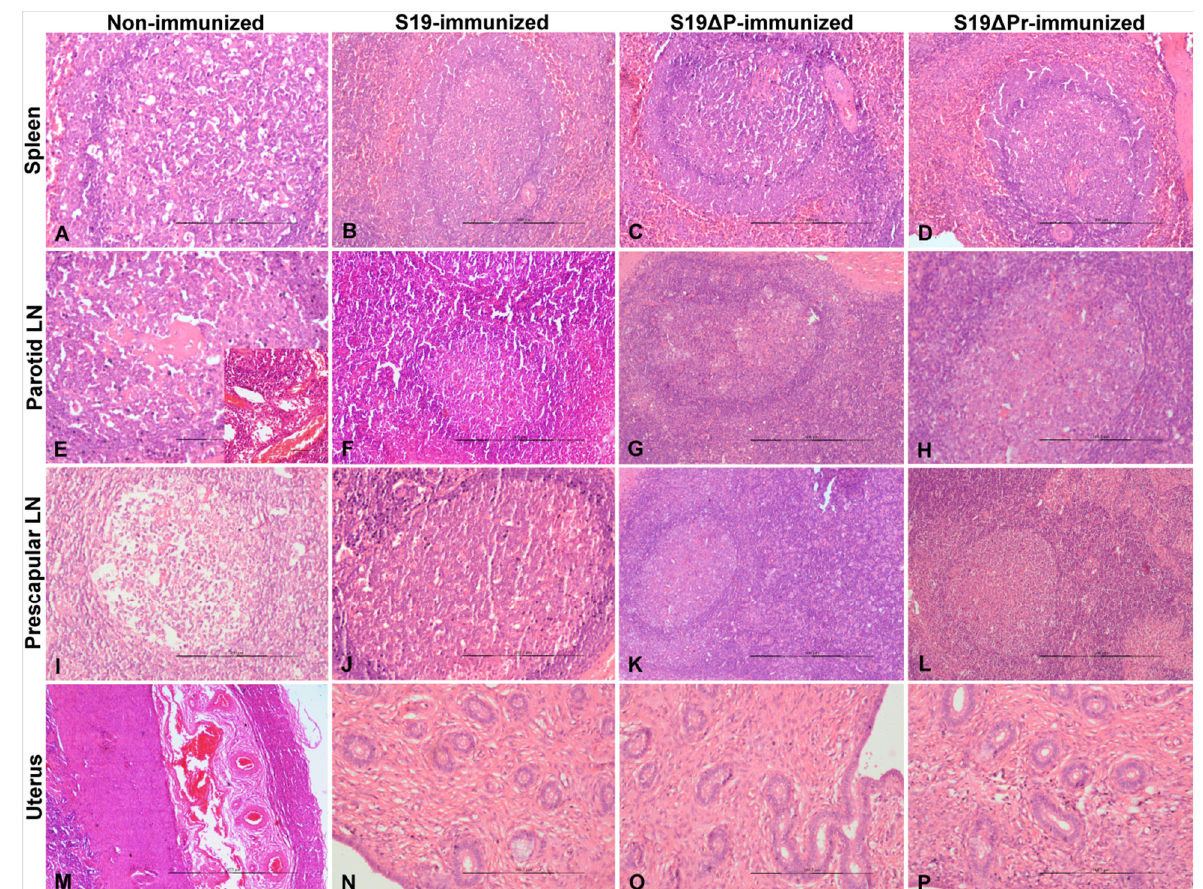
Figure 9. Post-challenge assessment of immunized buffaloes: histopathological lesions. ( A ) Spleen showed lymphoid depletion with apoptosis and necrosis of lymphocytes in white pulp. ( B – D ) Lymphoid hyperplasia with germinal center formation in white pulp. ( E ) Parotid lymph node (LN) showed lymphoid depletion with apoptosis and necrosis of lymphocytes in germinal center of lymphoid follicles. Severe congestion of blood vessels in cortex and medulla (inset). ( F–H ) Parotid LN showed hyperplasia of lymphoid follicles with germinal center formation in cortex. ( I ) Prescapular LN showed severe lymphoid depletion in germinal center of lymphoid follicles. ( J – L ) Prescapular LN showed hyperplasia of lymphoid follicles with germinal center formation in cortex. ( M ) Uterus showed marked congestion and dilatation of the blood vessels in muscular layer. ( N – P ) The normal endometrium is lined by ciliated single layer of columnar epithelium and endometrial glands. The tissue sections were stained with H&E staining and images were acquired at 40 × ( M ), 100 × ( B , C , F , G , I , K , L ) and 200 × ( A , D , E , H , J , N – P ) magnification using light